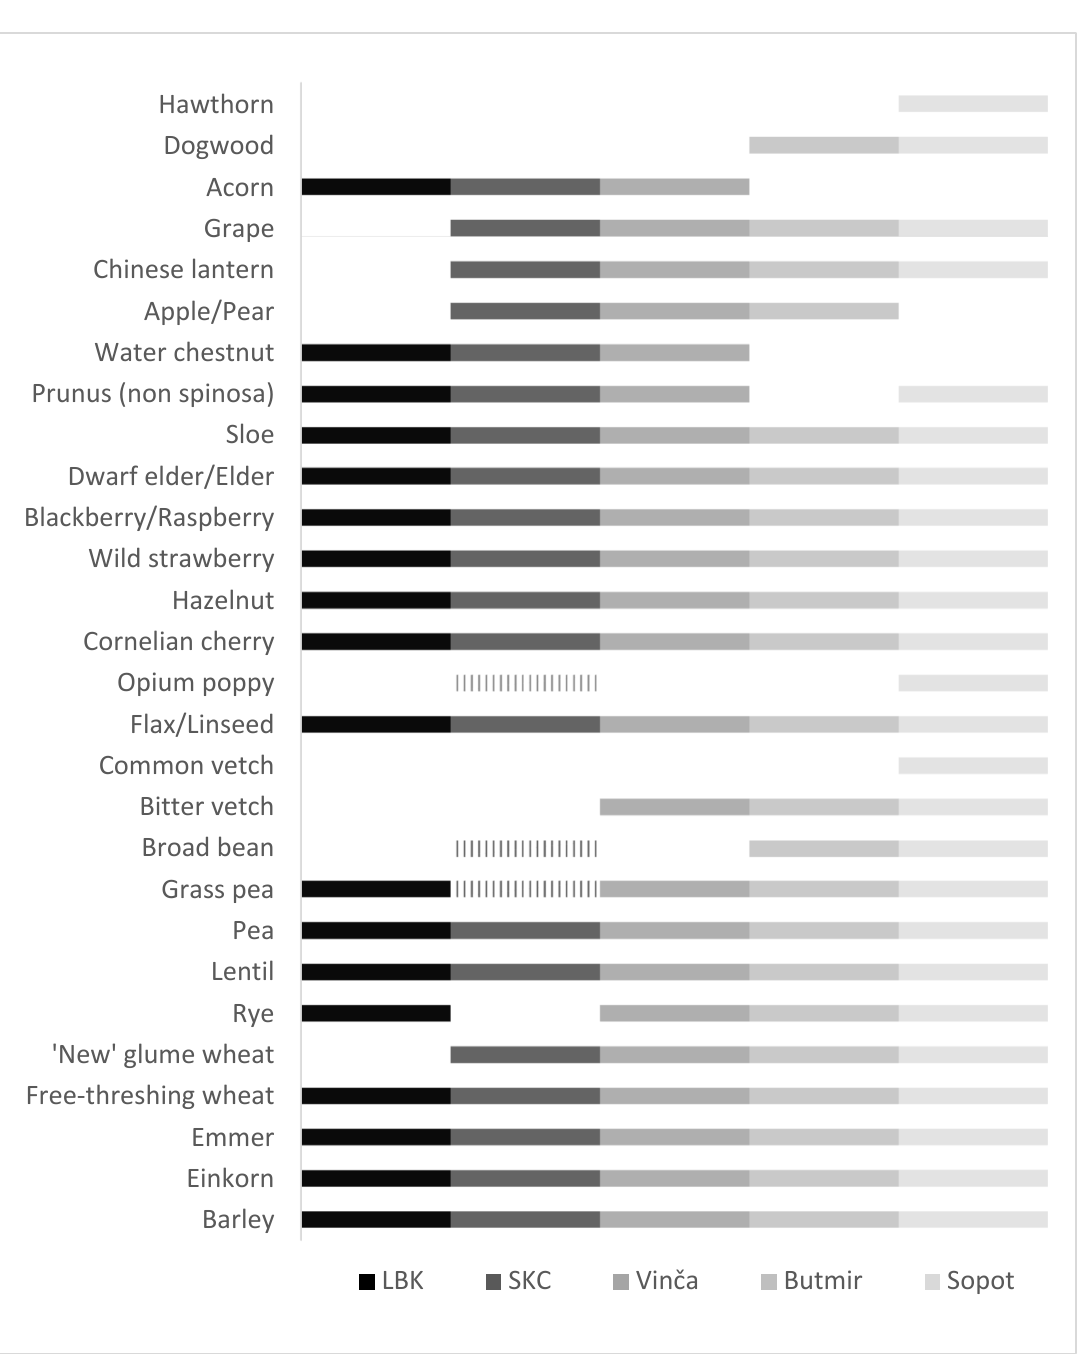
Figure 12. The crop and wild spectrum across the five archaeological cultures. Patterned fills denote uncertain identification or period; all 109 sites and 28 taxa are included (see Table S1).